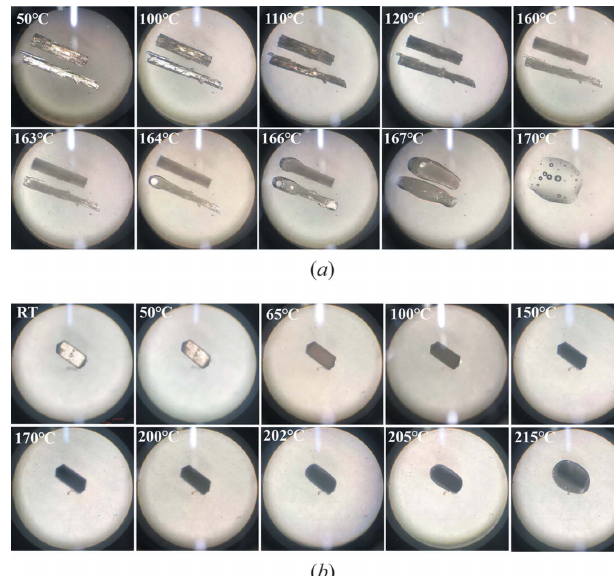
Figure 8 HSM pictures of the ( a ) anhydrate and ( b ) dihydrate crystals of PDA- OXA.